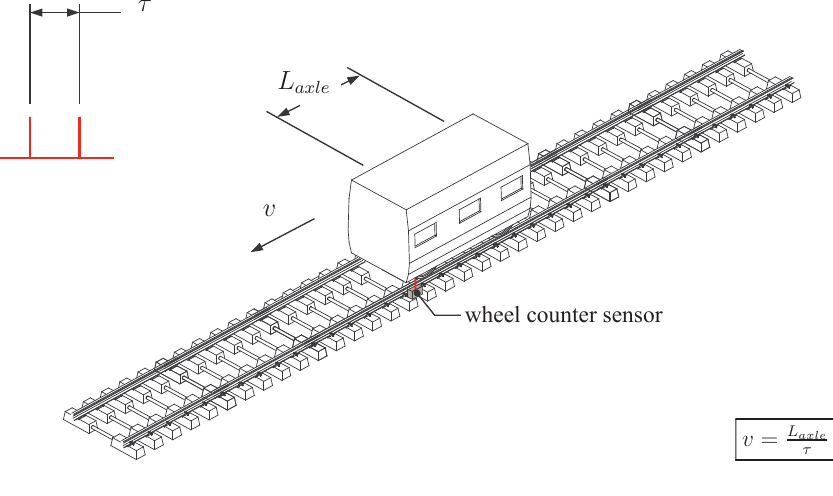
Figure 1. Speed evaluation based on wheel counters.